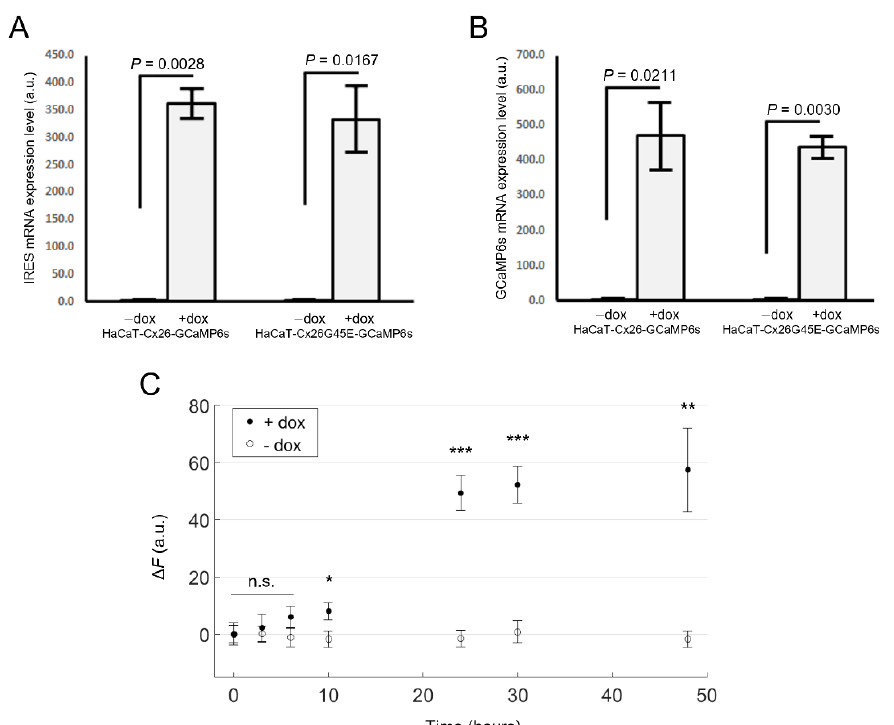
Figure 1. Validation of Tet-on bicistronic lentiviral constructs used to generate stable cell pools. mRNA expression levels of IRES ( A ) or GCaMP6s ( B ) assayed by qPCR (mean values ± standard deviation) in HaCaT-Cx26-GCaMP6s and HaCaT-Cx26G45E-GCaMP6s cells exposed to doxycycline for 24 h (+dox), or not exposed to doxycycline ( − dox). p -values ( p ) were calculated using the two-tailed t -test. ( C ) GCaMP6s fluorescence levels in live HaCaT-Cx26-GCaMP6s cells vs. time after addition of dox (2 µg/mL, filled symbols) or vehicle (empty symbols) to the culture medium. The mean values ± standard error of the mean (s.e.m.) for Δ 𝐹 = 𝐹 𝑡 − 𝐹 0 were computed for each condition as average fluorescence signal ( 𝐹 𝑡 ) of pixels that exceeded an arbitrary threshold minus the average value obtained before dox administration ( 𝐹 0 , t = 0). For each condition, values of n = 4 – 7 fields of view from one cell culture were averaged, and the statistical significance was calculated using a two-tailed t -test; *, P < 0.05; **, P < 0.01; ***, P < 0.001; and n.s., not significant.